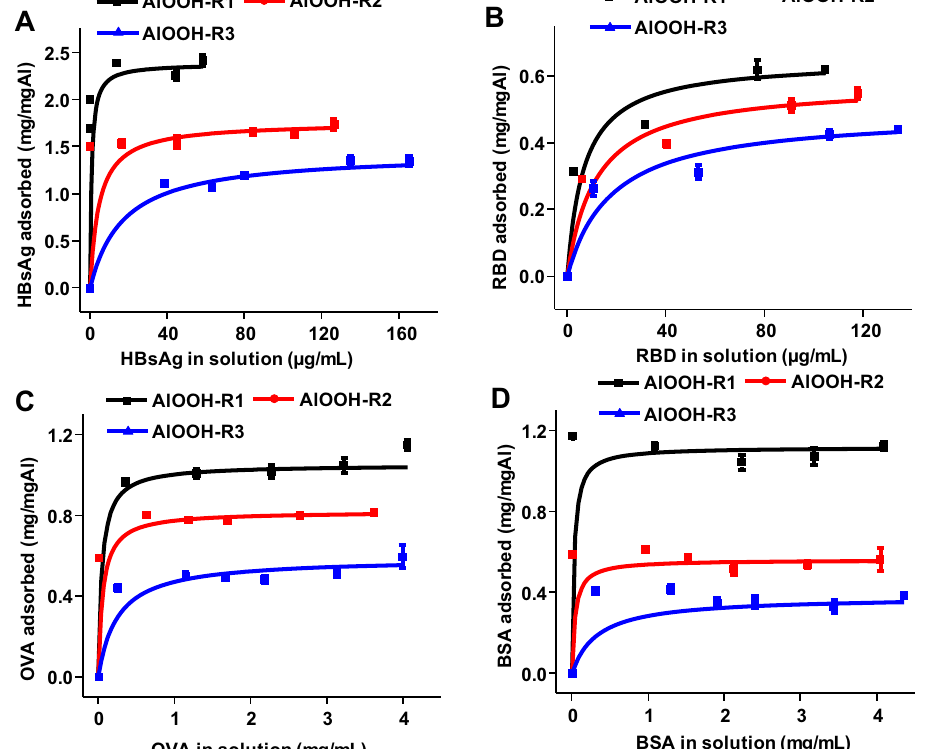
Fig. 2 Adsorption isotherms of antigens by AlOOH. The adsorption isotherms of A HBsAg, B RBD, C OVA, and D BSA by AlOOH nanorods in MOPS buffer at pH 7.4.